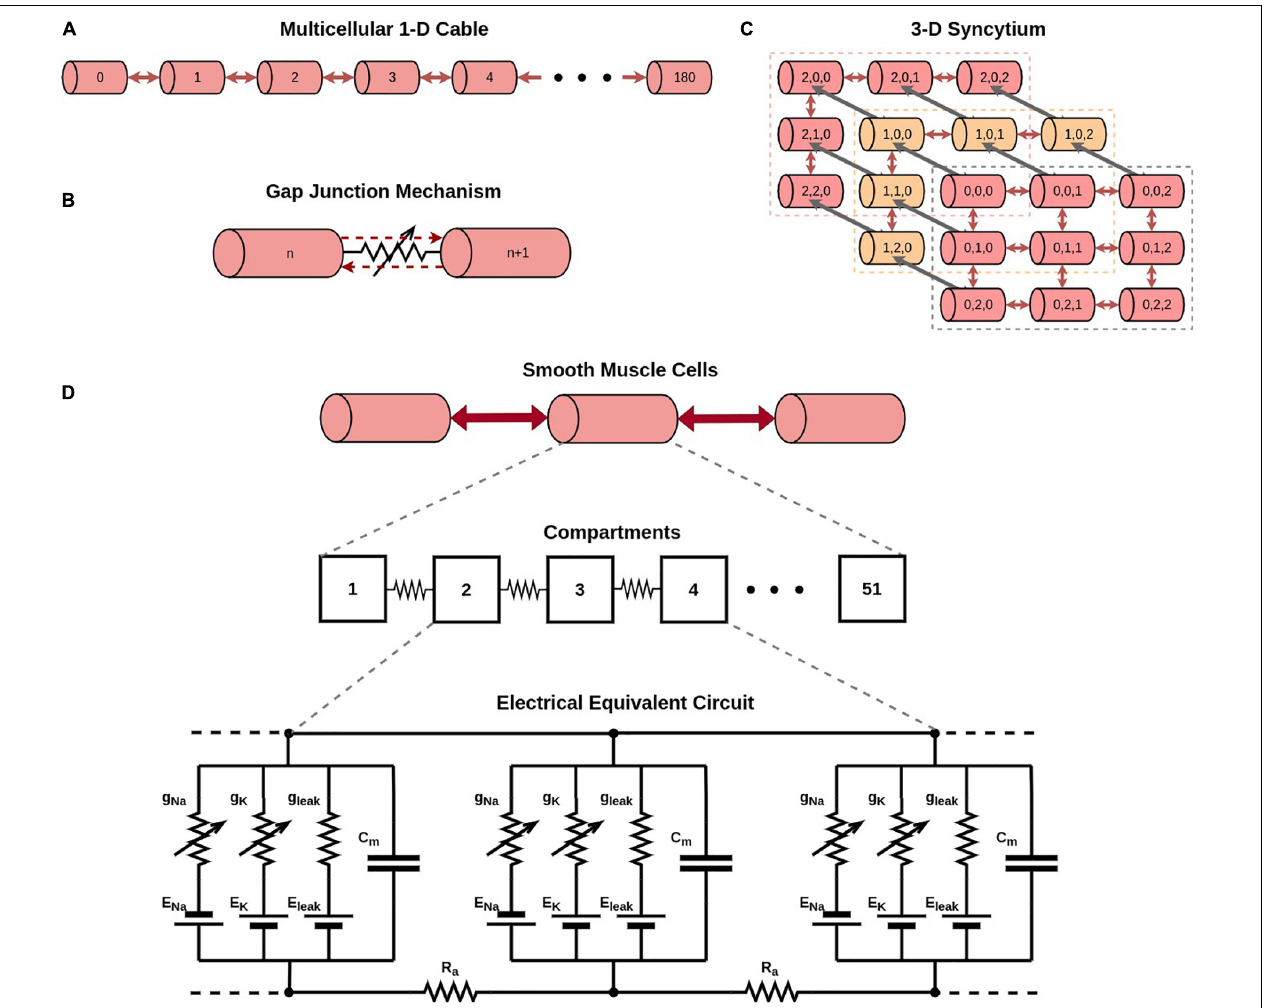
FIGURE 1 | Overview of model development. (A) Illustration of a 1-dimensional chain of 181 cells forming a long multi-cellular cable. (B) Simplified representation of the gap junction mechanism employed in NEURON simulator. (C) Illustration of a 3-dimensional syncytium consisting of 27 cells organized as a cube of size 3. In our study we have explored syncytia of various sizes. Do note that different colors have been employed for purposes of clarity in illustration, and do not signify differences in biophysical features. (D) Illustration of the compartmental modeling technique as applied to the model employed in our study. Each smooth muscle cell in our model is modeled to consist of 51 segments. The electrical equivalent circuit for the cell membrane of three such adjacent compartments, along with their interconnection, is depicted in the bottom panel. Each compartment has Hodgkin-Huxley channels, thereby enabling them to produce action